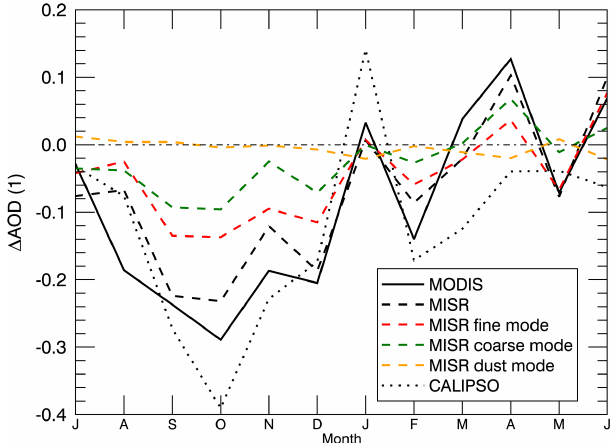
Figure 3. Seasonal variation of changes in AOD over south- ern China from 2006 to 2015 deduced from MODIS, MISR and CALIPSO data. MISR data include fine- and coarse-mode and dust particle